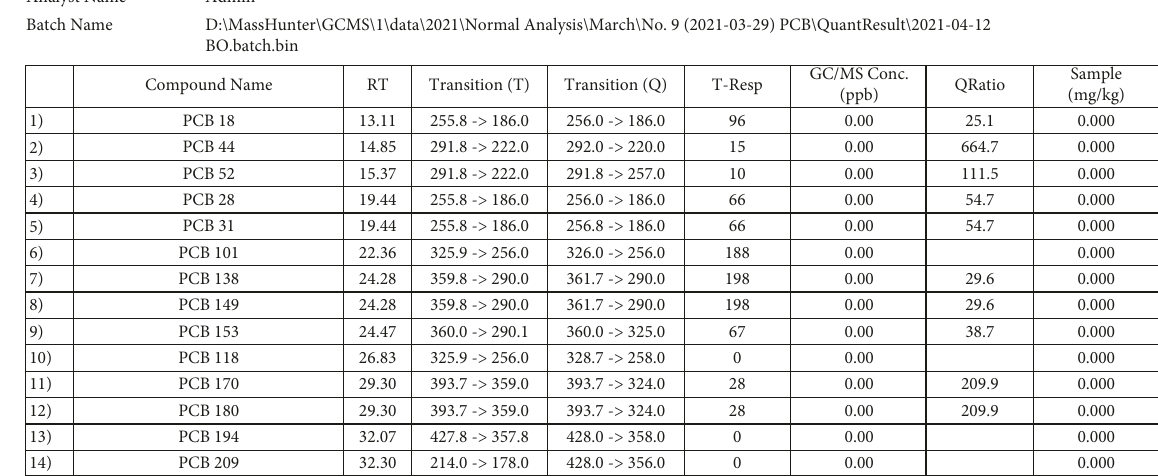
Figure 6: Solvent run using ethyl acetate